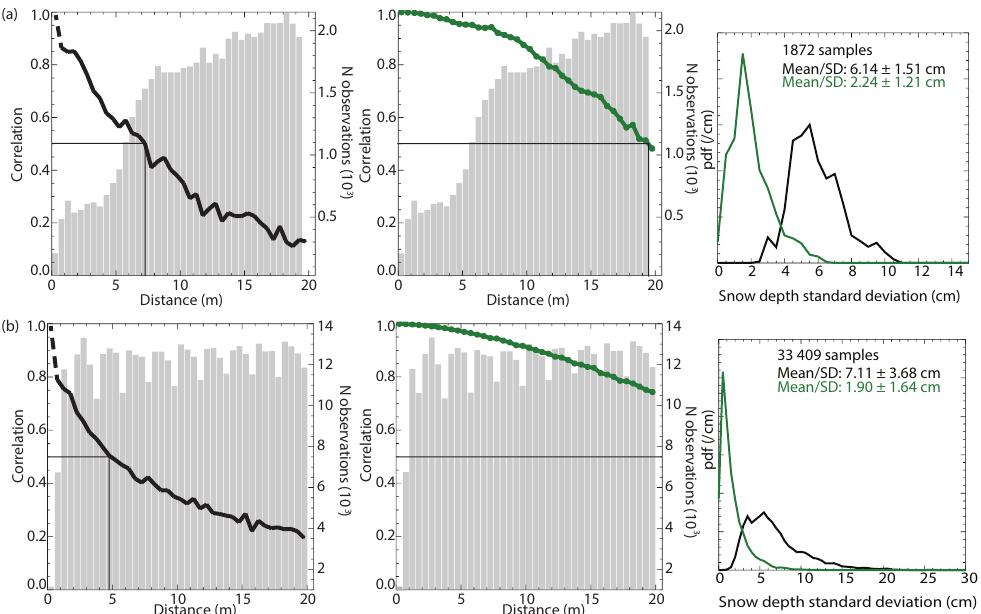
Figure 3. Spatial correlation (left and center) and variability (right panel) of snow depth measurements from (a) BROMEX and (b) Eureka before (black lines) and after (green lines) averaging (diameter of 40m). Gray bars show the number of measurements used in each correlation calculation. Pdf is probability density